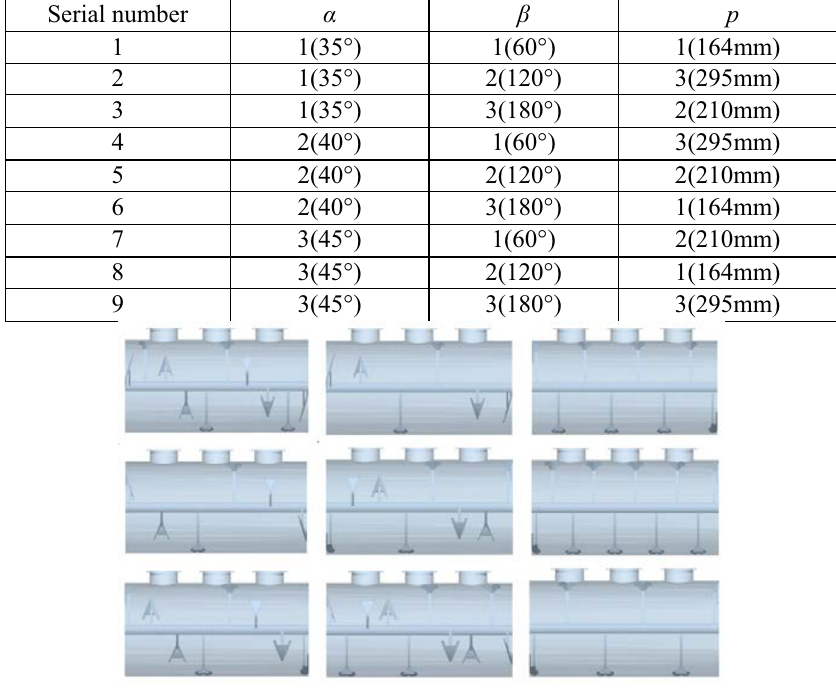
Fig. 5. Nine mixing structures.